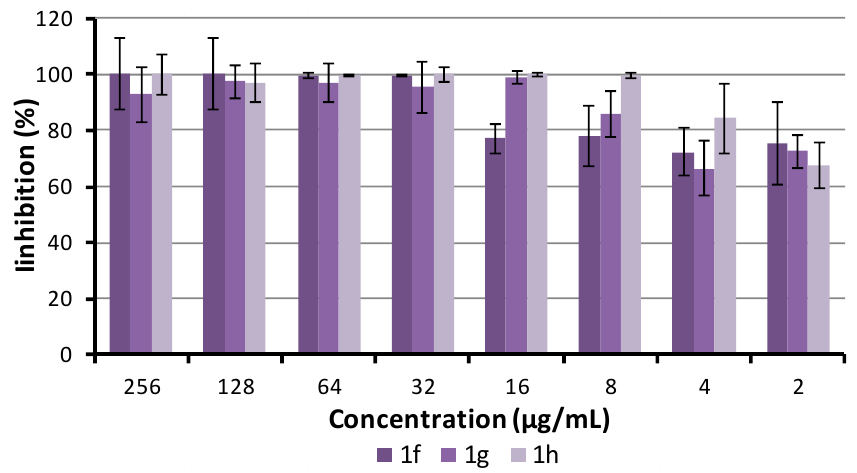
Figure 4. Inhibition activity of compounds 1f , 1g , and 1h on S. aureus ATCC 29213 biofilm.